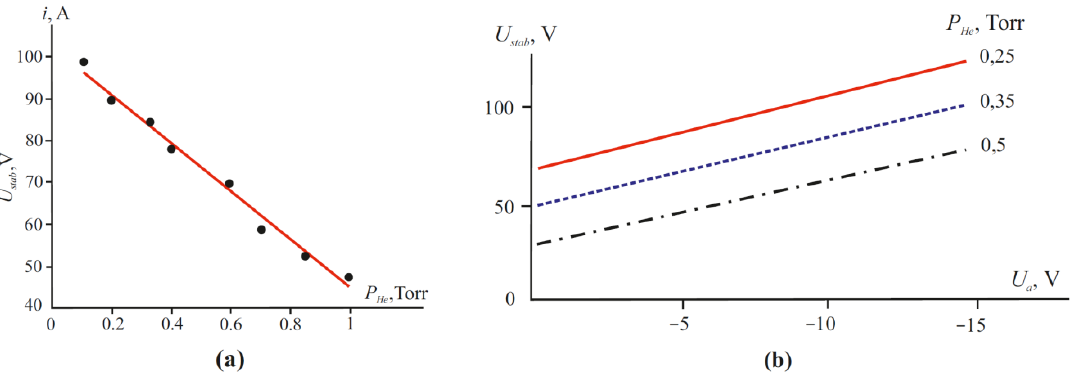
Figure 7. Dependence of the stabilized voltage: ( a ) On helium pressure P He ; ( b ) On the negative potential of the main anode U a